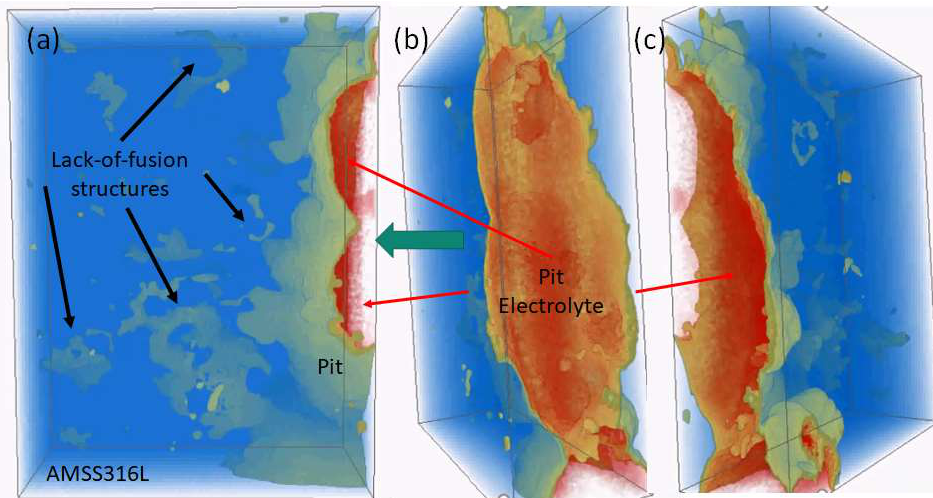
Figure 7. X-ray CT reconstruction of pitting produced in FeCl 3 ·6H 2 O moving through an additively manufactured SS316L alloy. The steel is coloured in blue but has been made transparent so that the internal structures can be observed. The buff features represent both the corrosion front (on the left in ( a )) and lack-of-fusion pore structures (several indicated using black arrows). ( b ) Rotated view relative to ( a ), showing the interior of the pit. The green arrow indicates the direction in which the viewer is looking into the pit. The red qualitatively reflects the distribution of concentrated corrosion product, which is mainly but not purely, ferric chloride (probably gel-like). ( c ) Further rotation that provides another aspect of the pit and internal corrosion product.